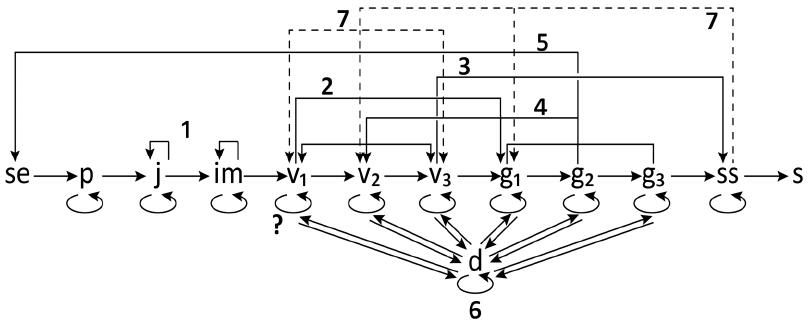
Figure 7. A lifecycle graph of Anemone patens incorporating the regular type of development and its